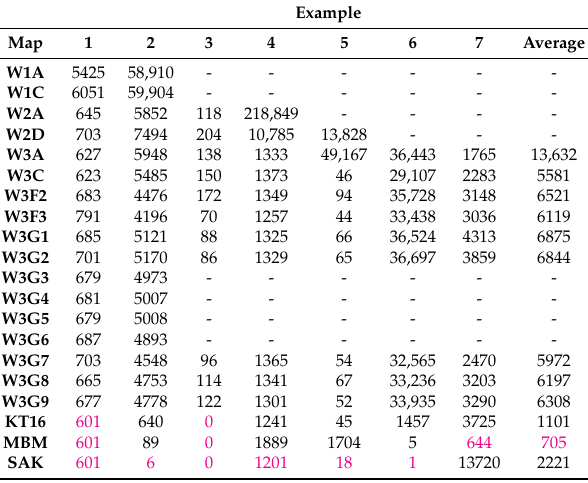
Figure 3. The top row for W2A (left), W2D (center left), W3A (center right) and W3C (right). The second row for W3F2 (left), W3F3 (center left), W3G1 (center right), and W3G2 (right). The third row for W3G7 (left), W3G8 (center left), W3G9 (center right), and KT16 (right). The bottom row for MBM (left), SAK (center left), for the roots of the polynomial equation ( z 3 − z ) . Table 7. Number of points requiring 40 iterations for each example (1–7).